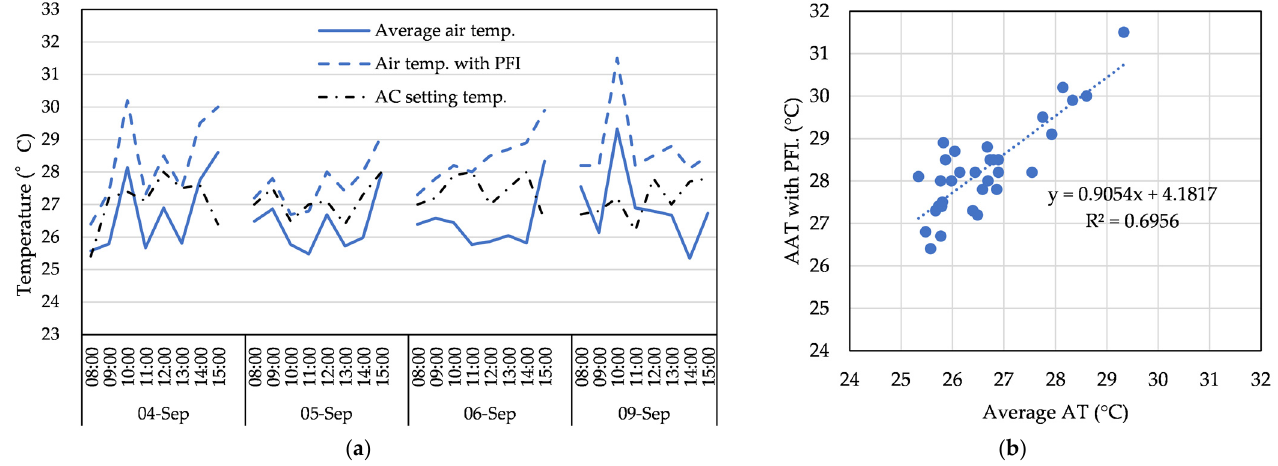
Figure 20. Summer indoor air temperature and correlation for the ( a ) summer average AT, AT with PFI, AC setting temp. of class A and ( b ) summer AT, AT with PFI correlation of class A.